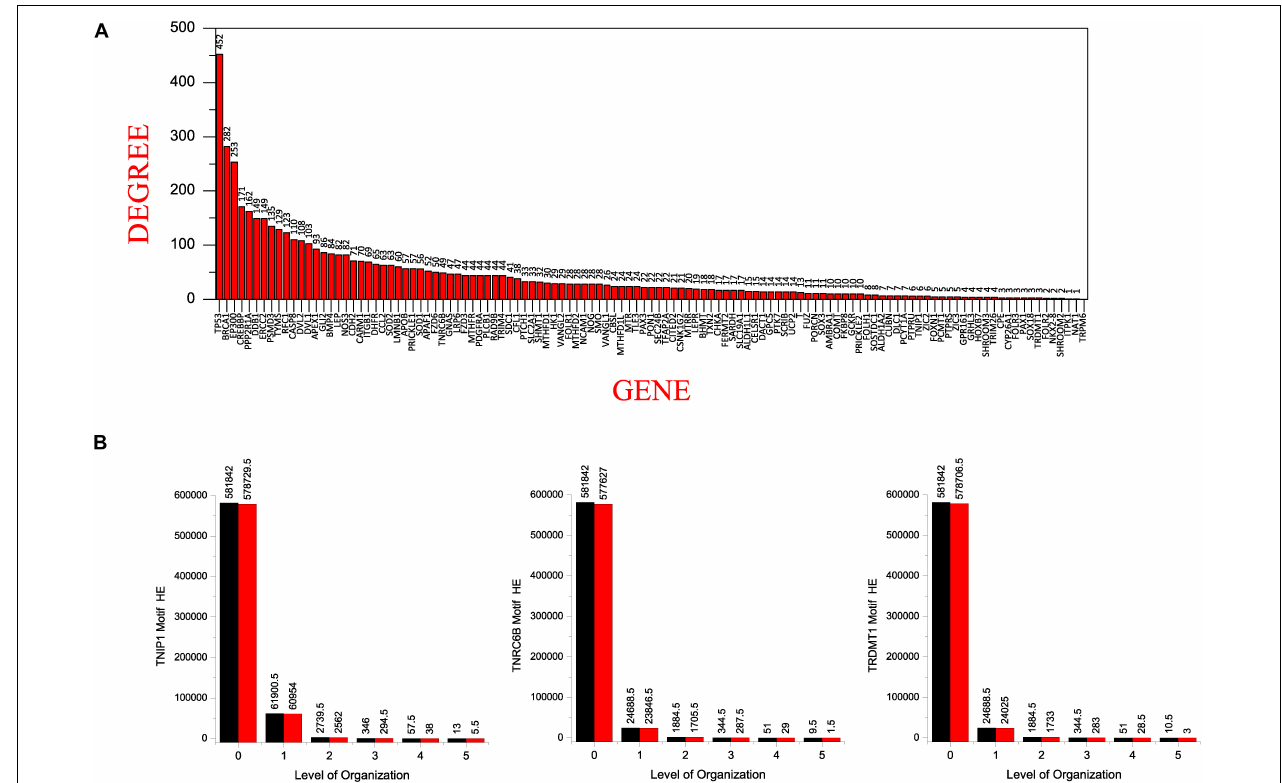
FIGURE 7 | (A) showing the seed genes in the decreasing order of their degree with TP53 having the highest degree. (B) comparison of the Hamiltonian Energy (HE) of the original (black) and the corresponding motifs knockout networks (red) at different levels of the hierarchical organization of the SB network.